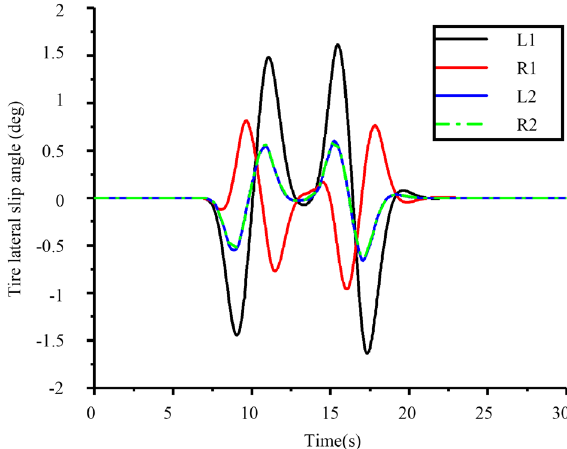
Figure 23. Tire lateral slip angle.